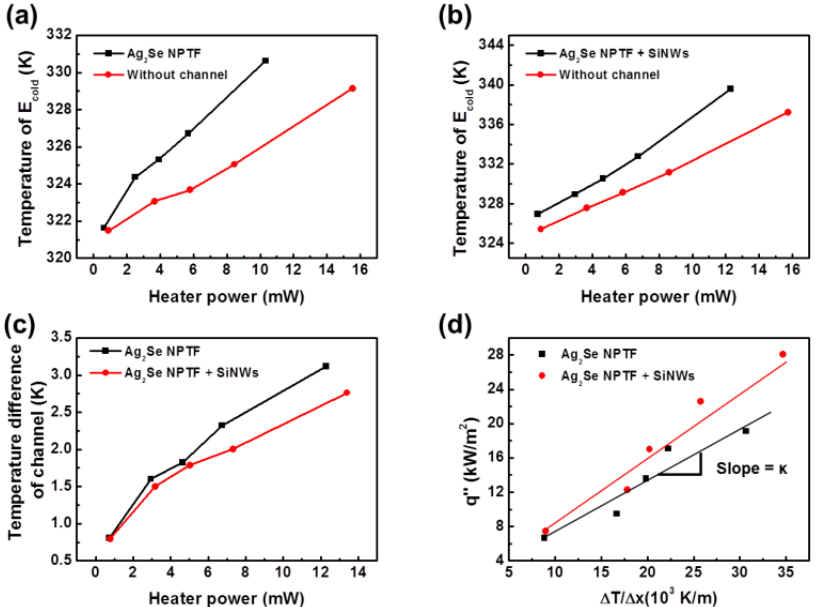
Figure 5. Temperature of E2 for ( a ) the Ag 2 Se NPTF alone and ( b ) the Ag 2 Se NPTF embedded with SiNWs. ( c ) Temperature difference of the channel as a function of heater power. ( d ) q ″ versus Δ T/ Δ x.